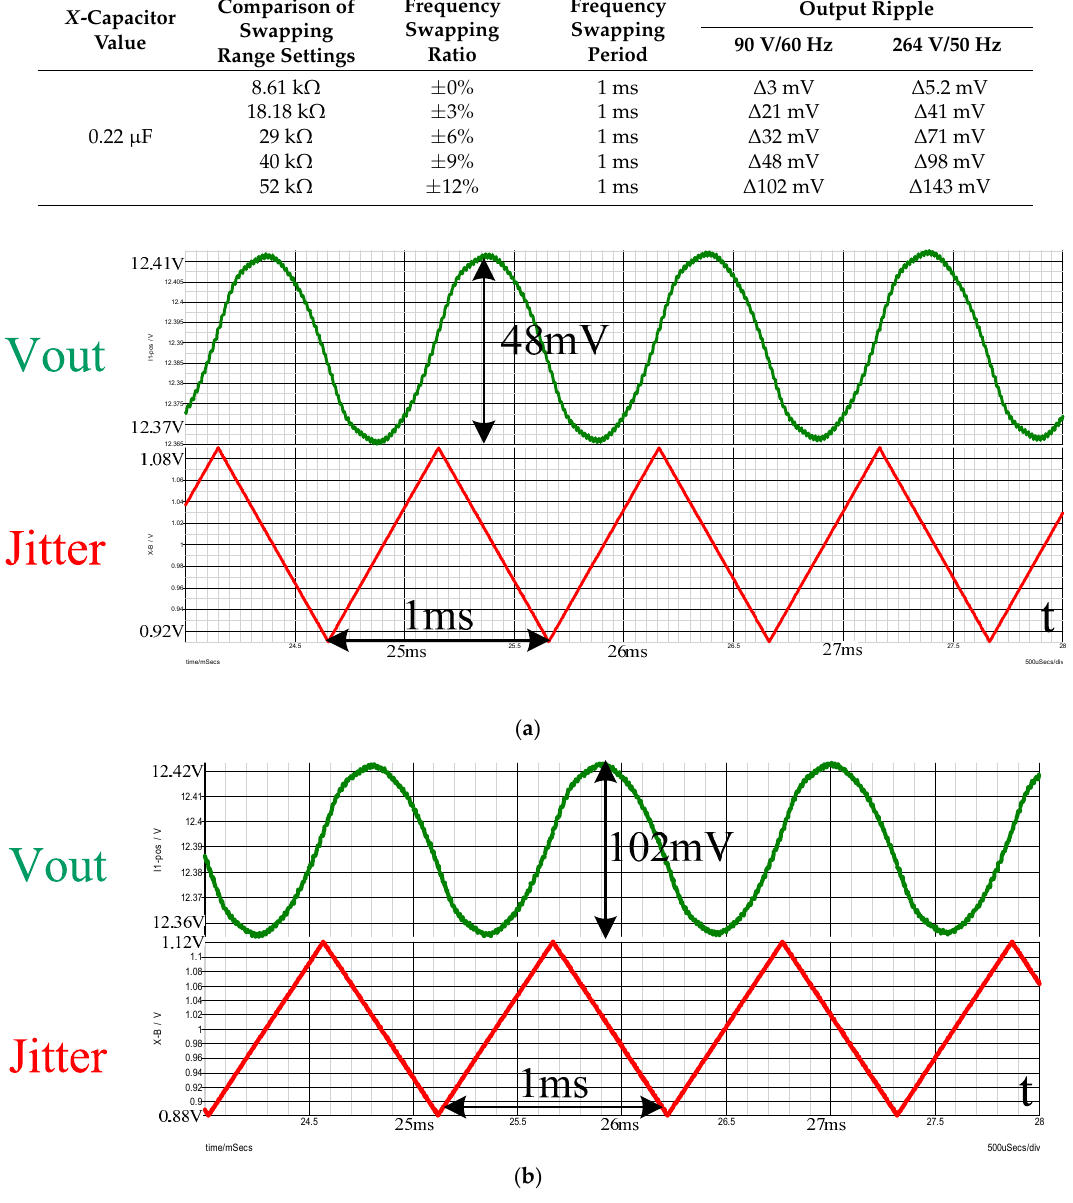
Figure 17. Modified frequency swapping ratio comparison: ( a ) output ripple for ±9% frequency swapping range (90 V/60 Hz); ( b ) output ripple for ±12% frequency swapping range (90 V/60 Hz).